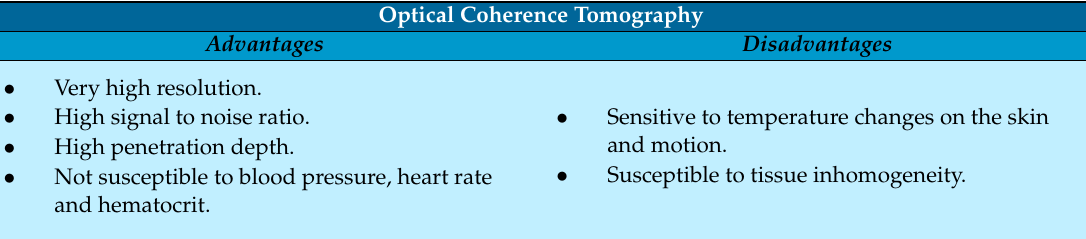
Table 8. Advantages and disadvantages of Optical Coherence